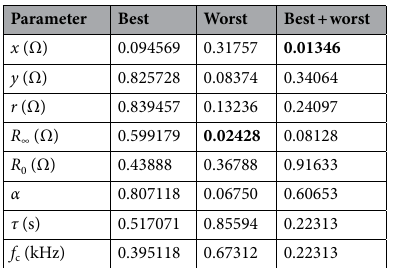
Table 4. P -values for the comparison of the parameters obtained for the best, the worst and both cases considered together with the spectra taken from all subsets of data (0–12). Significant values are in bold.